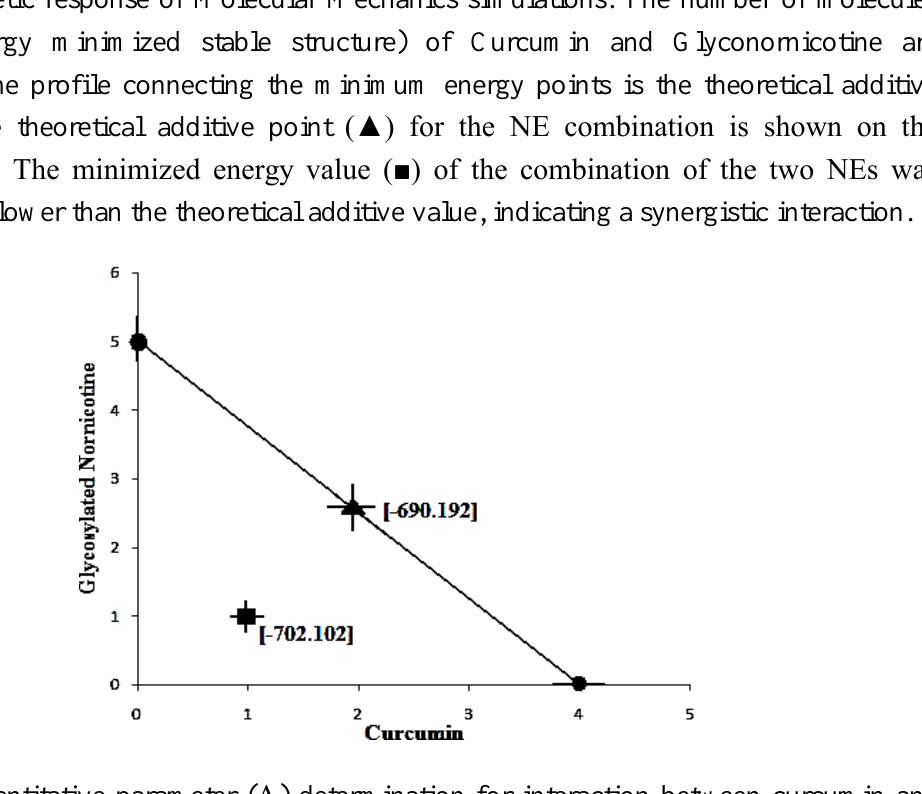
Table 7. Quantitative parameter (Λ) determination for interaction between curcumin and glycosylated